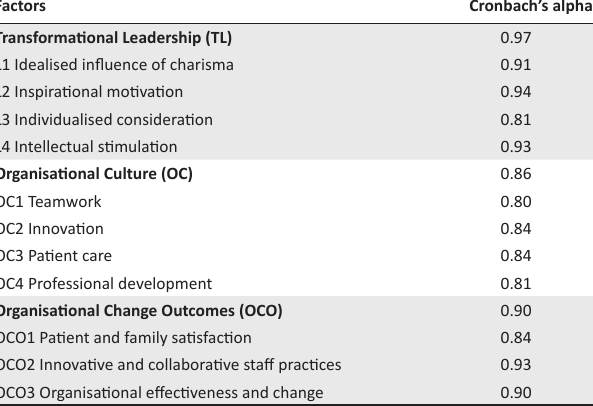
TABLE 2: Cronbach’s alpha coefficients for the factors or subscales.